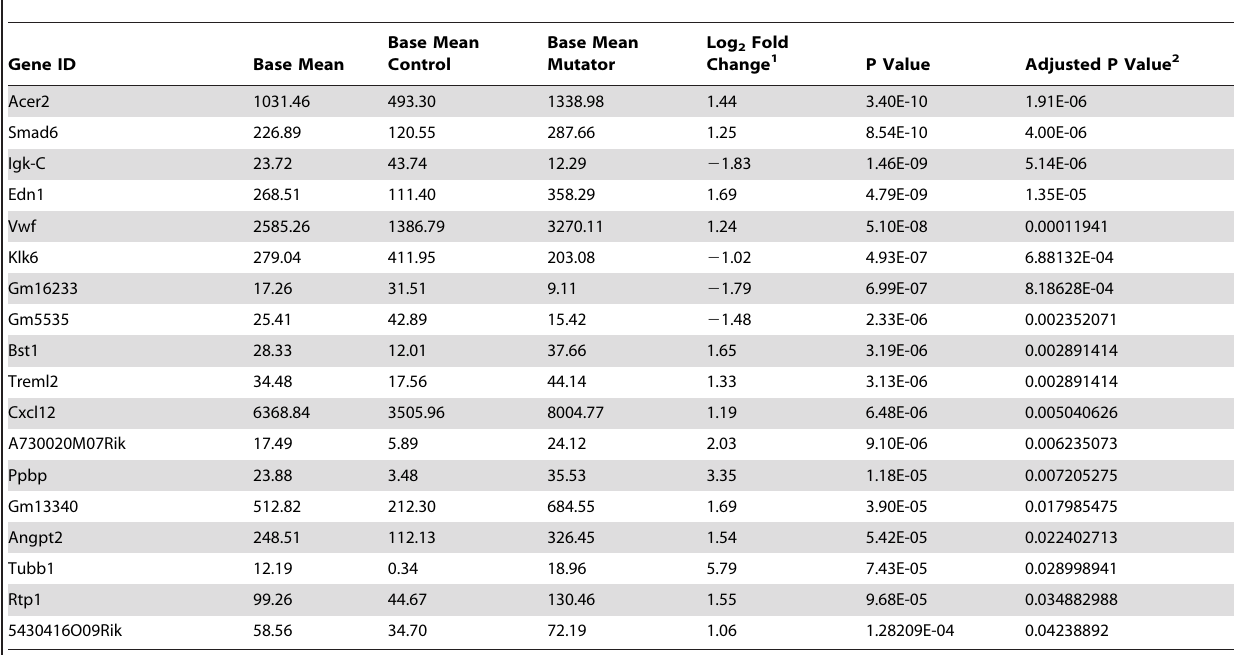
Table 2. Differentially expressed mRNA transcripts in the brains of aged Polg mutator mice as determined by RNA-seq.